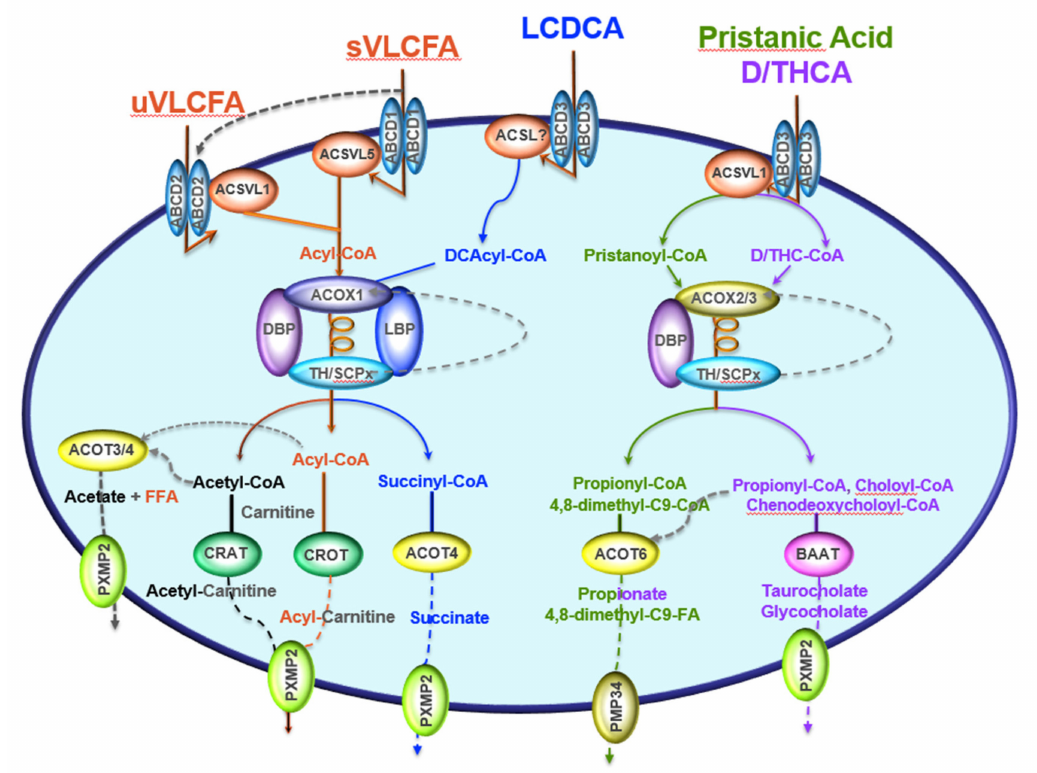
Figure 1. Peroxisomal β -oxidation pathways, including different enzymes and transporters. Saturated or unsaturated very- long-chain fatty acids (sVLCFA or uVLCFA) are imported by the solute ABC-transporters ABCD1 and ABCD2, respectively, into peroxisome, where they are transformed into their acyl-CoAs by one of the peroxisomal acyl-CoA synthetases (ACSVL5 for uVLCFA, and ACSVL1 for uVLCFA). The long-chain dicarboxylic acids (LCDCA), originating from the endoplasmic reticulum ω -oxidation, are imported by ABCD3 and activated to their acyl-CoA thioesters (DCAcyl-CoA) by an unknown acyl-CoA synthetase (ACSL?). The reactions that are catalyzed by ACSVL and ACSL use CoASH and hydrolyze ATP to AMP and pyrophosphate to activate VLCFA or LCDCA molecules, giving acyl-CoA. Acyl-CoA oxidase 1 (ACOX1) is the first flavoenzyme in the straight-chain β -oxidation system, oxidizing sVLCFA, uVLCFA, or LCDCA to their enoyl-CoA derivatives. The second enzyme metabolizing sVLCFA and uVLCFA is the D-bifunctional protein (also called MFP2 or HSD4B17), while the dicarboxylic enoyl-CoA are taken by the L-bifunctional enzyme (also called MFP1 or EHHADH). The thiolytic cleavage is catalyzed by one of the two peroxisomal thiolases (TH: thiolase/ACAA1/2 or SCPx: sterol carrier protein-x). After several rounds of β -oxidation, the peroxisomal system gives shortened acyl-CoA derivatives as hexanoyl- or octanoyl-CoA, and one molecule of acetyl-CoA/round. Both shortened acyl-CoA and acetyl-CoA can be hydrolyzed by acyl-CoA thioesterases 3 or 4 (ACOT3/4) to CoASH, while free fatty acid and acetate are exported by the pore-forming protein PXMP2 (or PMP22) to the cytosol. However, acetyl-CoA and acyl-CoA derivatives can also be transformed to acetyl-carnitine or acyl-carnitine by carnitine acetyl- and carnitine octanoyl transferases (CRAT and CROT), respectively, and then exported by PXMP2 to the cytosol. β -oxidation of DCAcyl-CoAs leads to the production of succinyl-CoA, hydrolyzed to succinate and CoASH by ACOT4, and shipped outside by peroxisome PXMP2. Bile acid intermediates, dihydroxycholestanoic acid (DHCA) and trihydroxycholestanoic acid (THCA), imported by ABCD3 transporter, are beta- oxidized by ACOX2, DBP and SCPx enzymes, leading to the formation of choloyl-CoA and chenodeoxycholoyl-CoA, which are conjugated to glycine or taurine by the bile acid-CoA: amino acid N- acyltransferase (BAAT) and then exported by PXMP2. D/THC-CoA indicate DHCA and THCA co-enzyme A